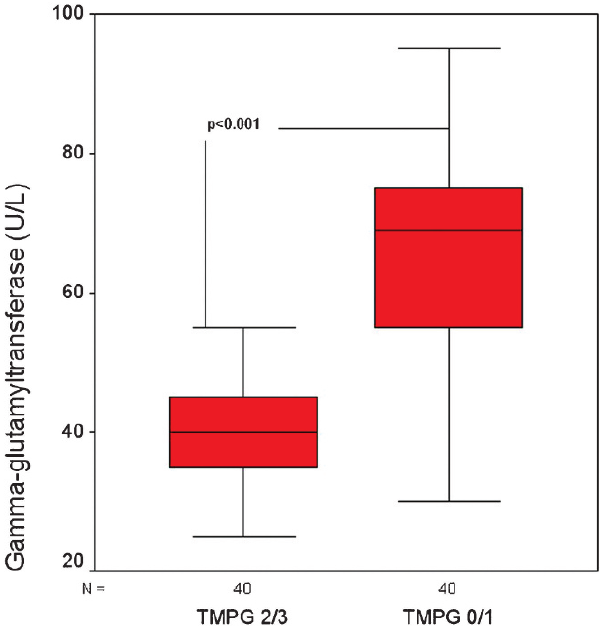
Figure 1 - Comparison of Gamma-glutamyltransferase levels between study groups. ( TMPG : TIMI myocardial perfusion grade).